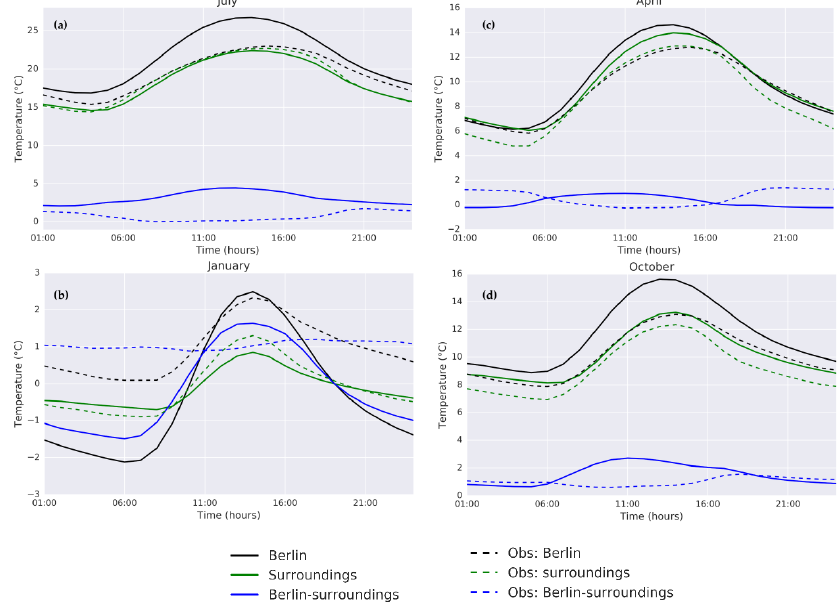
Figure 4. Temperature diurnal cycle. Hourly average between 1971–2000 for the monthly mean of ( a ) July, ( b ) January, ( c ) April, and ( d ) October. The hourly mean of regional climate model REMO (solid lines) is compared to the observational data (dashed lines) for Berlin (black) and its surroundings (green) as well as the hourly mean of the surroundings subtracted from the hourly mean of Berlin (blue).